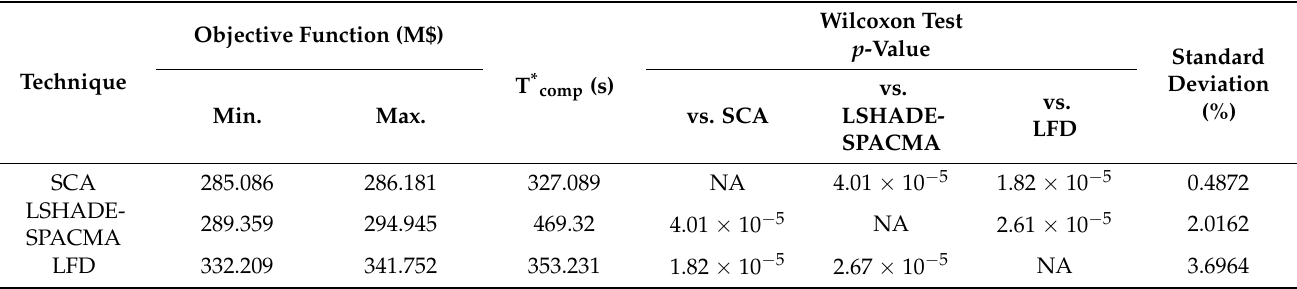
Table 2. Convergence results of SCA, LSHADE-SPACMA, and